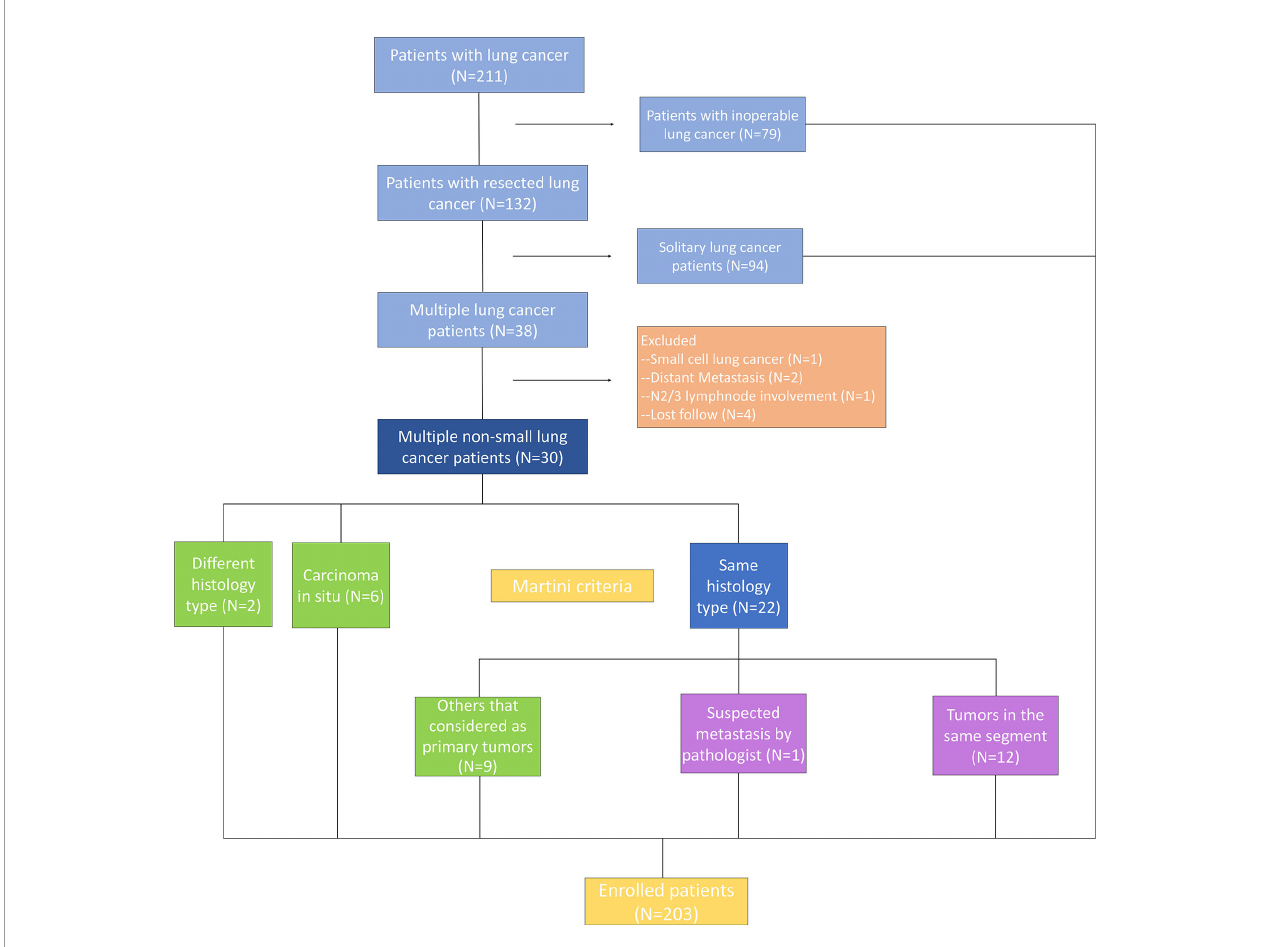
FIGURE 1 | The fl owchart of the patients ’ inclusion